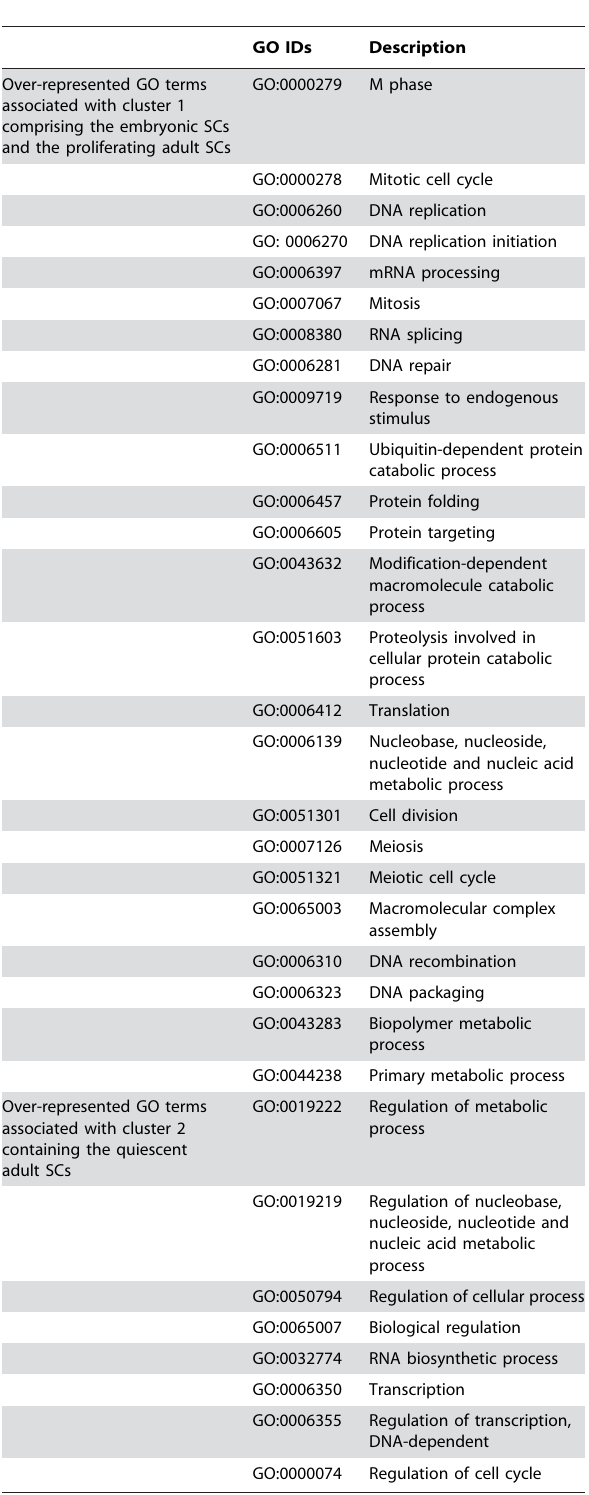
Table 12. Over-represented GO term identifiers in 24 data sets.